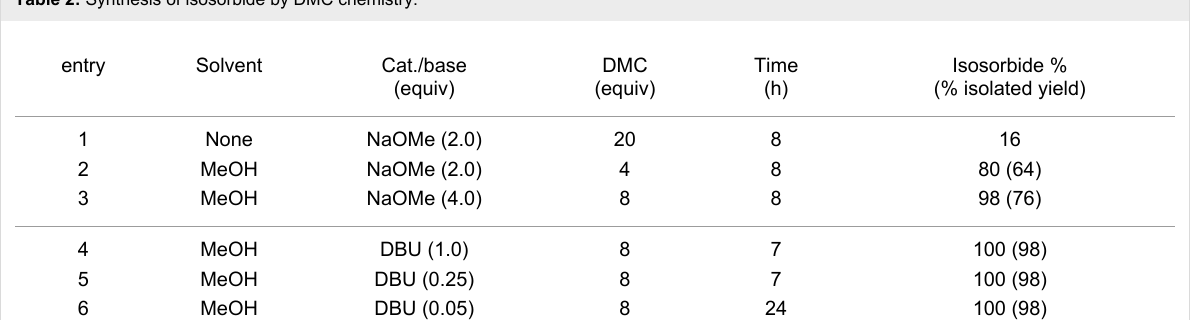
Table 2: Synthesis of isosorbide by DMC chemistry.